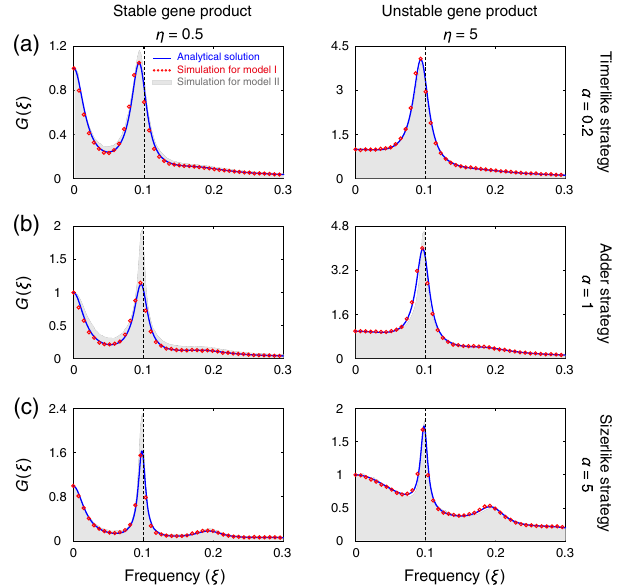
FIG. 6. Power spectra for the model with a cell-size description and its approximation by the model without a cell-size descrip- tion under different size homeostasis strategies. (a) Timerlike control for stable (left panel) and unstable (right panel) gene products. (b) Adder control. (c) Sizer-like control. In (a) – (c), the gray region represents the simulated spectrum for the model with a cell-size description, the red circles represent the simulated spectrum for the model without a cell-size description, and the blue curve represents the analytical spectrum given in Eq. (9). See Sec. S7 in the Supplemental Material [66] for the technical details of this